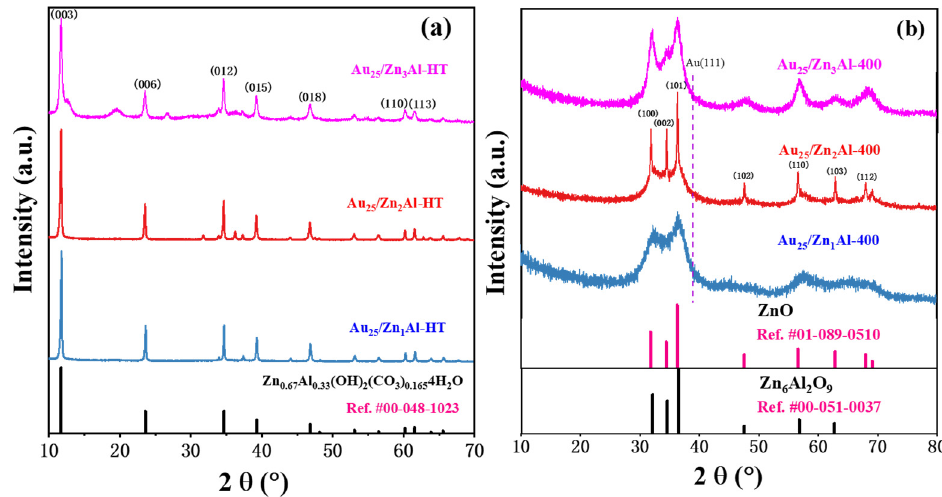
Figure 2. XRD patterns of Zn-Al-HTs supported gold nanoclusters before ( a ) and after ( b ) heat treatment.